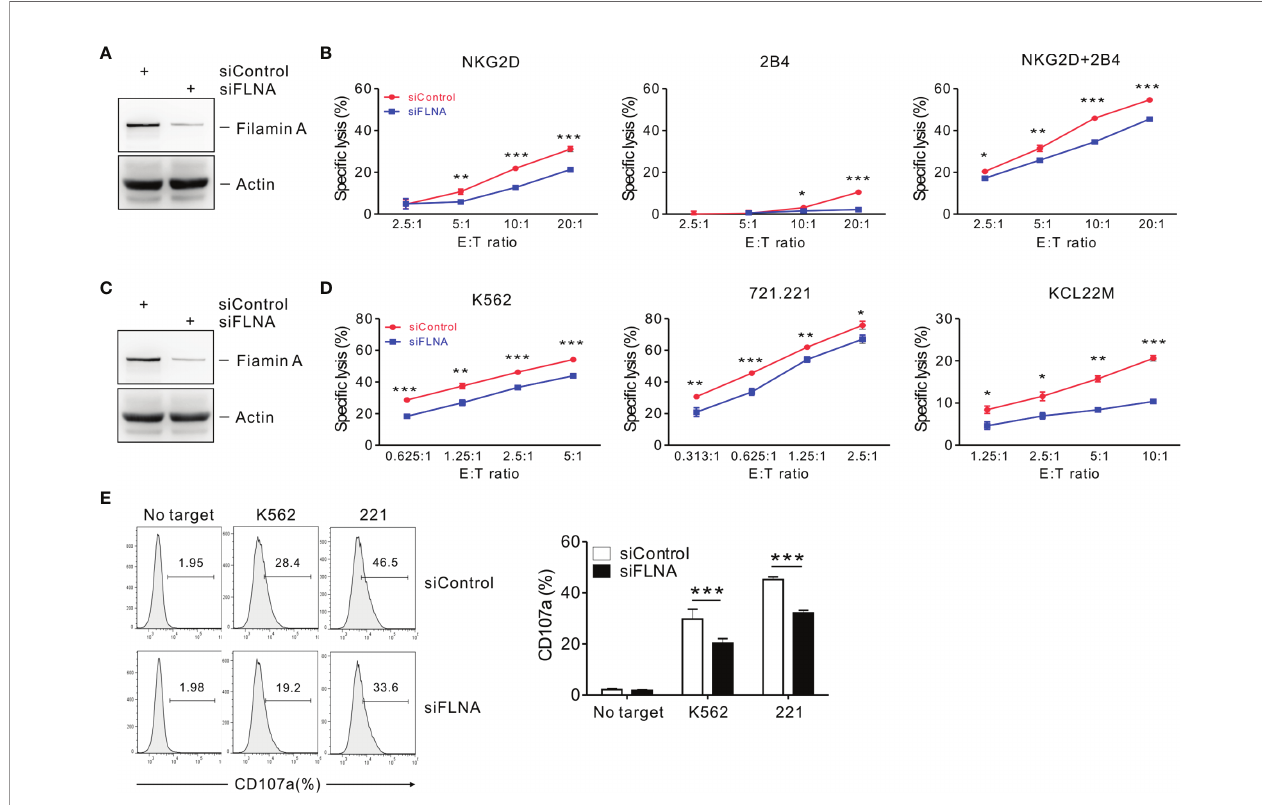
FIGURE 2 | FLNa regulates NK cell cytotoxicity. (A) Lysates of NKL cells nucleofected with a control siRNA or FLNa-speci fi c siRNA were immunoblotted for FLNa and actin. (B) P815 cell lysis by NKL cells nucleofected with a control siRNA or siRNA speci fi c for FLNa at the indicated E:T ratio. The cytotoxicity was then measured against P815 cells preincubated with speci fi c mAbs to NKG2D, 2B4, or their combination after 2 h using the Europium assay. (C) Total lysates of CD16.NK92 cells nucleofected with control siRNA or siRNAs speci fi c for FLNa were immunoblotted for FLNa and actin. (D) Lysis of K562, 721.221, or KCL22M cells by CD16.NK92 cells nucleofected with control siRNA or FLNa-speci fi c siRNA at the indicated E:T ratio. The cytotoxicity against K562, 721.221, or KCL22M cells was measured using 2 h-europium release assay. (E) CD16.NK92 cells nucleofected with control siRNA or siRNA speci fi c for FLNa were mixed with K562 or 721.221 cells with labeled anti-CD107a to conduct a degranulation assay for 2 h. Thereafter, the cells were surface stained with labeled anti-CD56 mAbs. CD107a expression on CD16.NK92 cells was determined on CD56+ cells by fl ow cytometry. Representative FACS pro fi les ( left ) and a summary graph ( right ) of the expression of CD107a on CD16.NK92 cells are shown. Error bars represent the SD; * P < 0.05, ** P < 0.01, *** P < 0.001. Data are representative of at least three independent